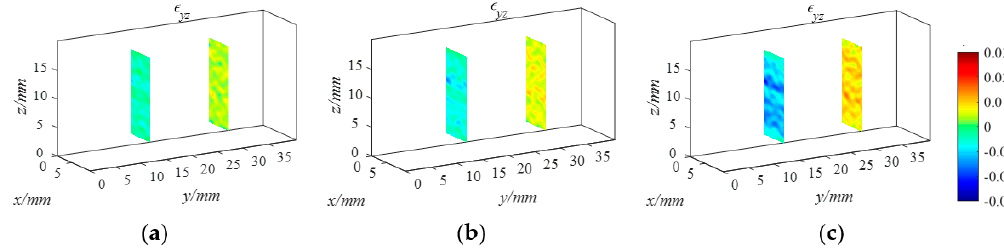
Figure 11. ε yz strain contours of two transverse sectional images at step 7, step 9 and step 10, respectively; ( a ) step 7; ( b ) step 9 ( c ) step